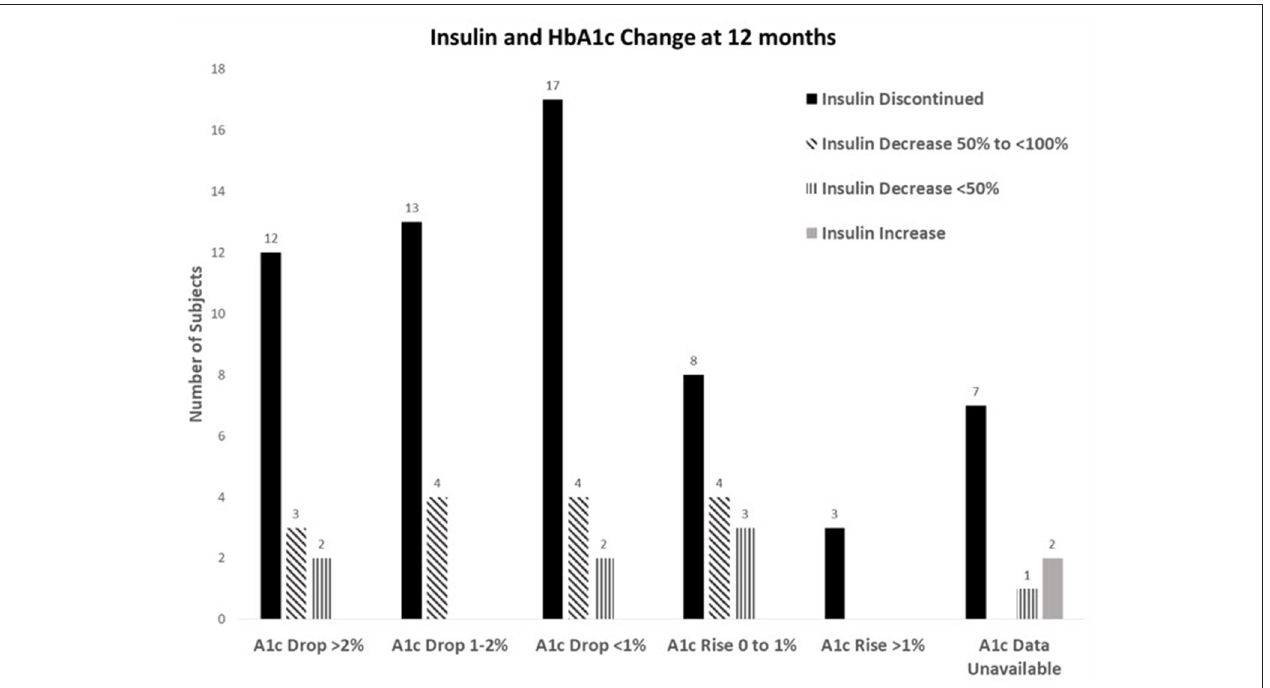
FIGURE 1 | Insulin and HbA1c change at 12 months.